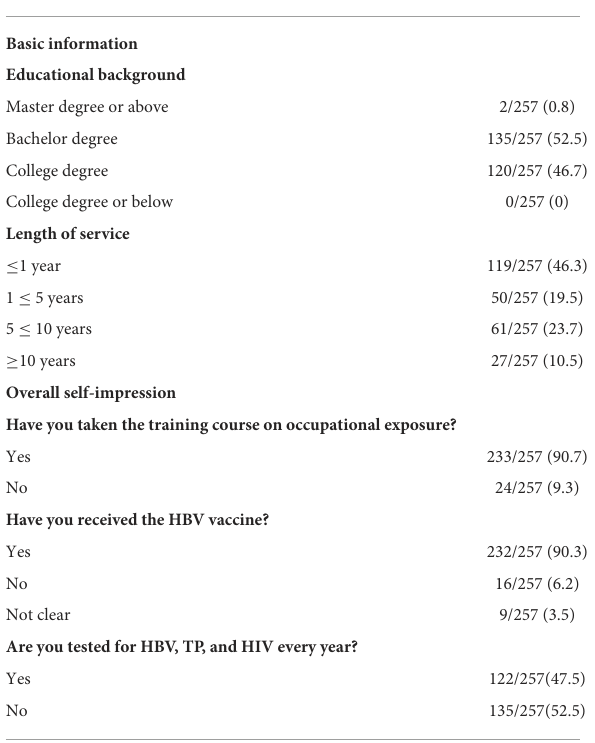
TABLE 1 Basic characteristics of the study participants ( n = 257).